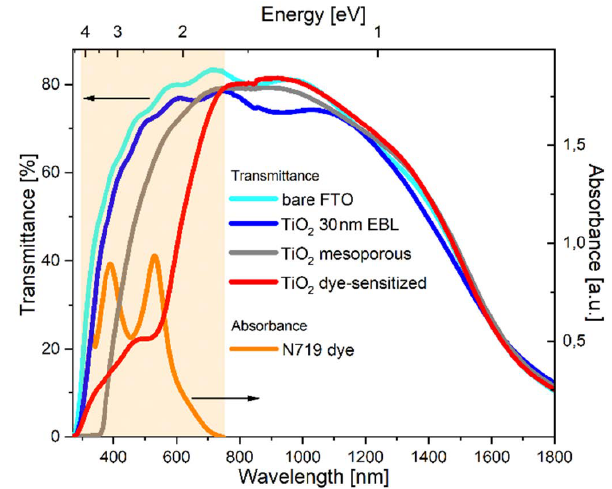
Figure 6. Optical properties of the individual components of the fabricated DSSC photoanode: transmittance spectra of the bare FTO (light blue), TiO 2 30 nm EBL (navy blue), mesoporous TiO 2 (gray) and mesoporous dye-sensitized TiO 2 (red), compared to the absorbance spectrum of the N719 dye (orange).